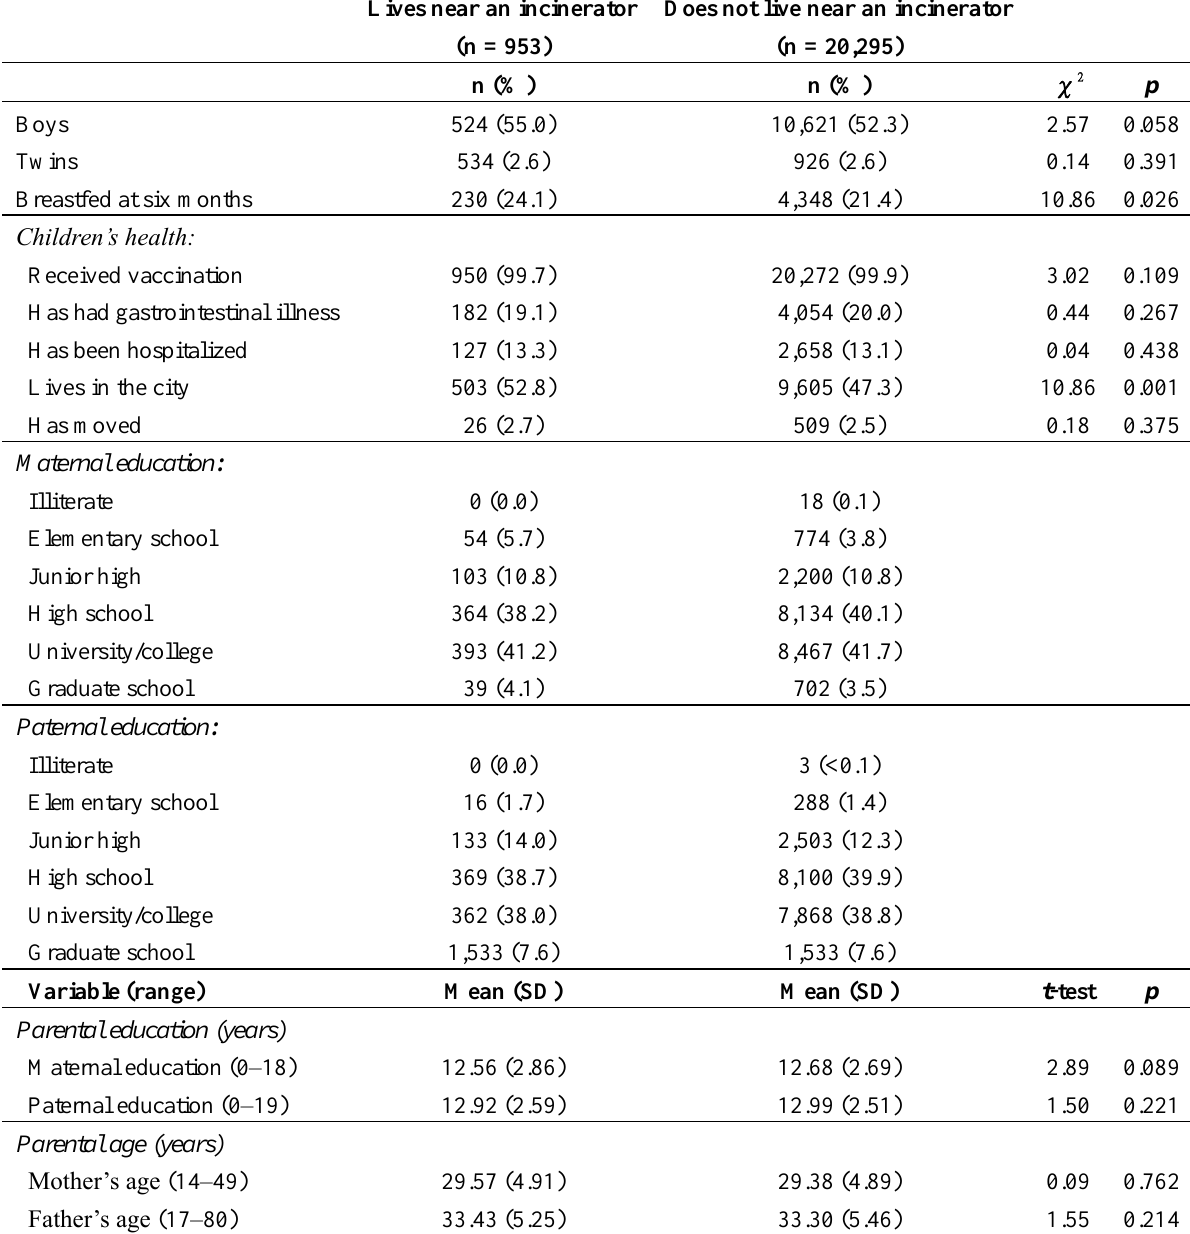
Table 1. Comparison of the demographics of the children and their parents who lived near an incinerator and those who did not (N =